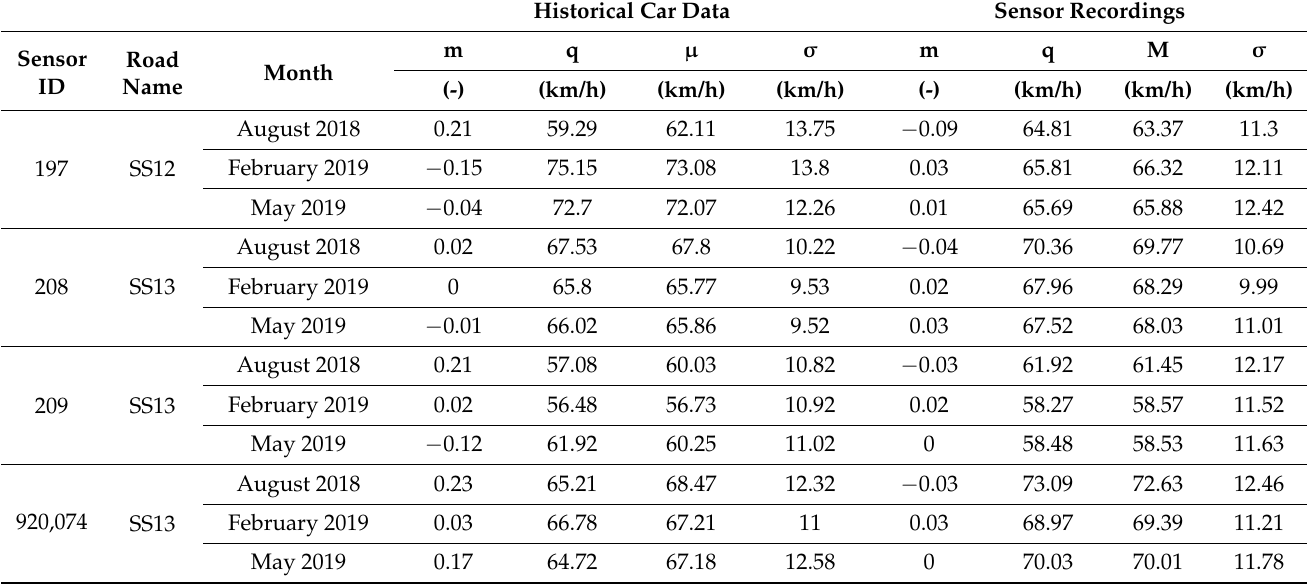
Table A1. HCD and sensors angular coefficients m, and intercepts q of the regression lines, average speeds µ , and the standard deviations σ referred to each monitored month in Dir